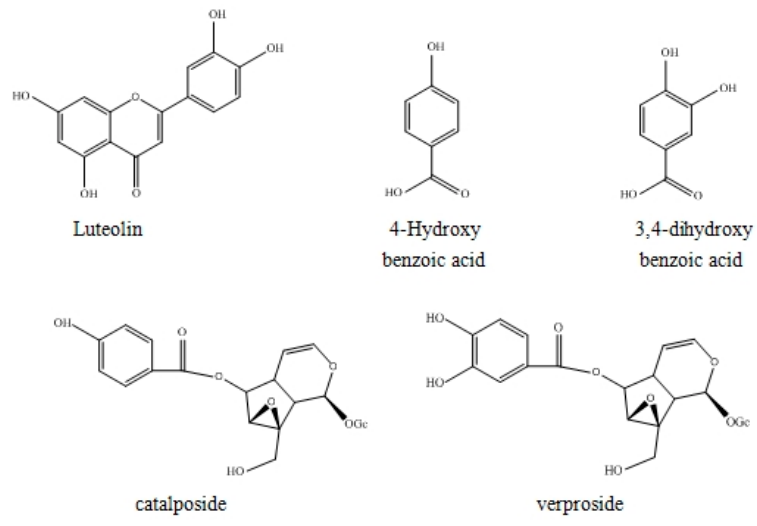
Figure 3. Structures of the five compounds.